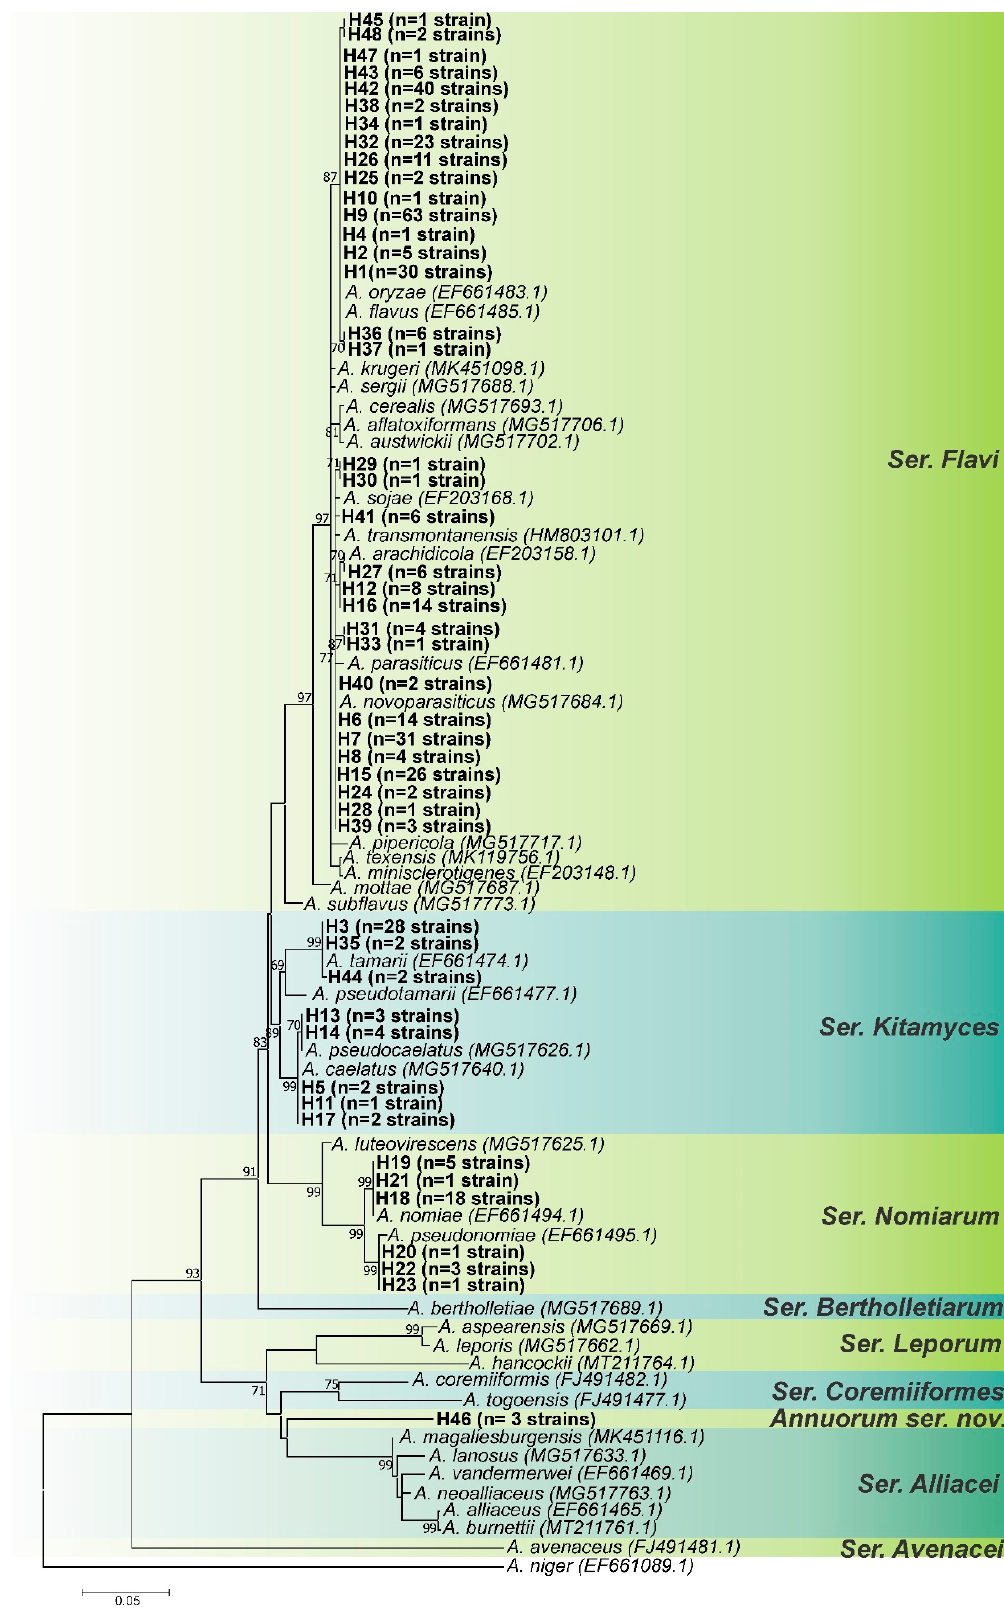
Figure 2. Maximum-likelihood tree of Aspergillus section Flavi based on BenA sequences. Haplotypes obtained in this study are indicated by the letter H in bold. Only bootstraps ≥ 60% are shown. Aspergillus niger is the outgroup.